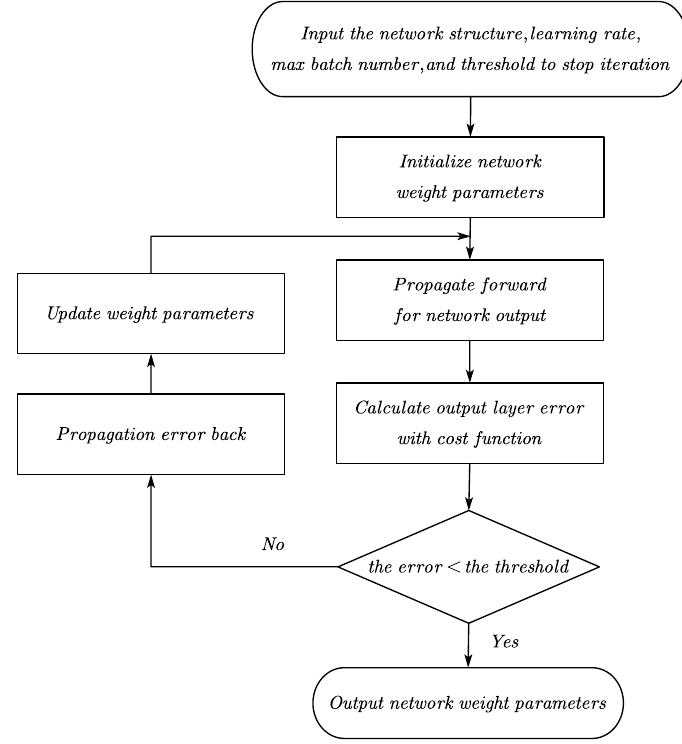
Figure 1. Training process of CNN.